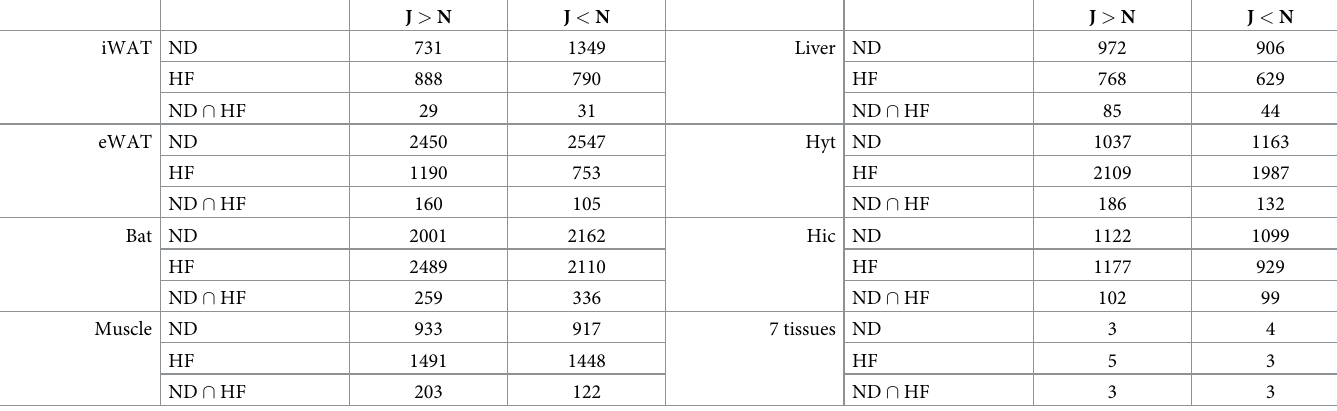
Table 1. Number of differentially expressed genes (DEGs) in the iWAT, eWAT, BAT, muscle, liver, Hyt, and Hic between B6J and B6N mice fed a normal diet (ND) or a high-fat diet (HF). J >